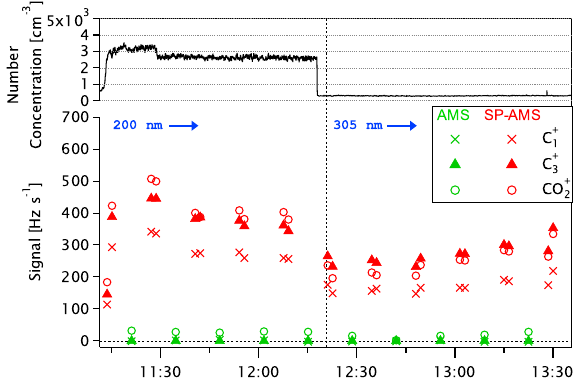
Fig. 2. Lower ordinate: time series of C + ( ◦ ) for Regal Black during two size-selected experiments for AMS (green symbols) and SP-AMS (red symbols) measurements. Upper ordinate: CPC particle number concentration time